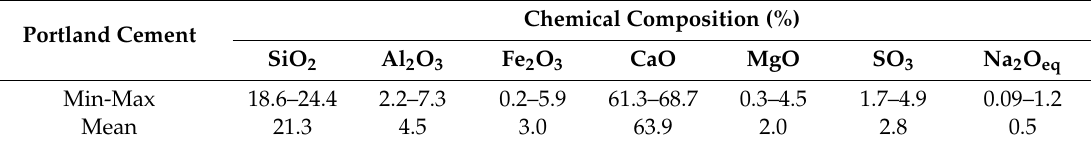
Figure 1. Oxides composition of MSW incinerator bottom ash (MIBA) from various studies [88–109]. Table 1. Chemical composition of Portland cement [119].